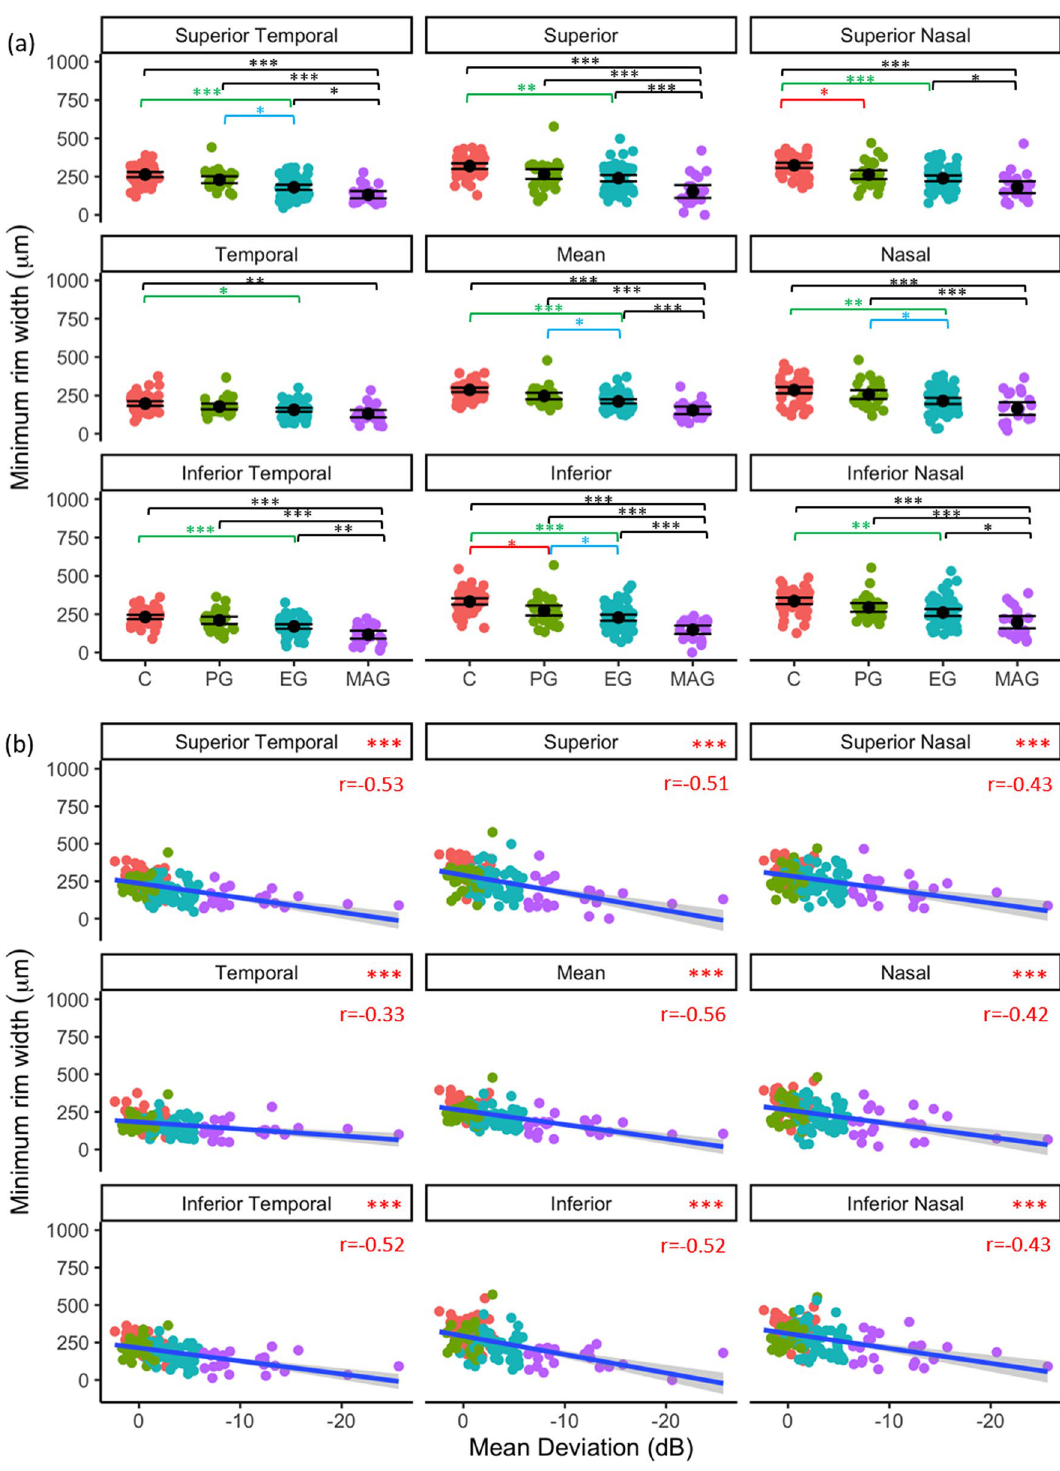
Figure 4. Regional MRW as a function of glaucoma disease stage ( a ); black point represents mean and error bars indicate 95% confidence intervals, and ( b ) visual field status (VF MD). Blue line represents regression line and grey shading indicates 95% confidence intervals. Red text indicates significant Pearson’s correlation (r) values at p < 0.05. * p < 0.05, ** p < 0.01, *** p <